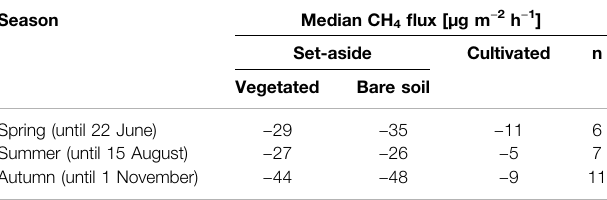
TABLE 6 | Season-speci fi c median methane (CH 4 ) fl ux [µg m − 2 h − 1 ] from the set- aside site (bare soil and vegetated) and the cultivated